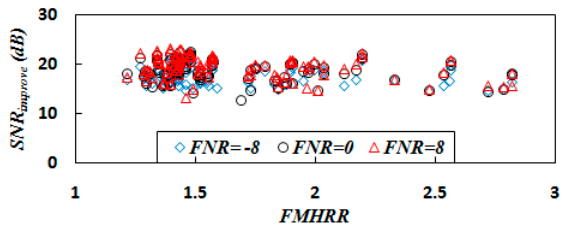
Figure 9. The change of SNR improvement with the FECG and MECG heart rate ratio (FMHRR) when FNR is